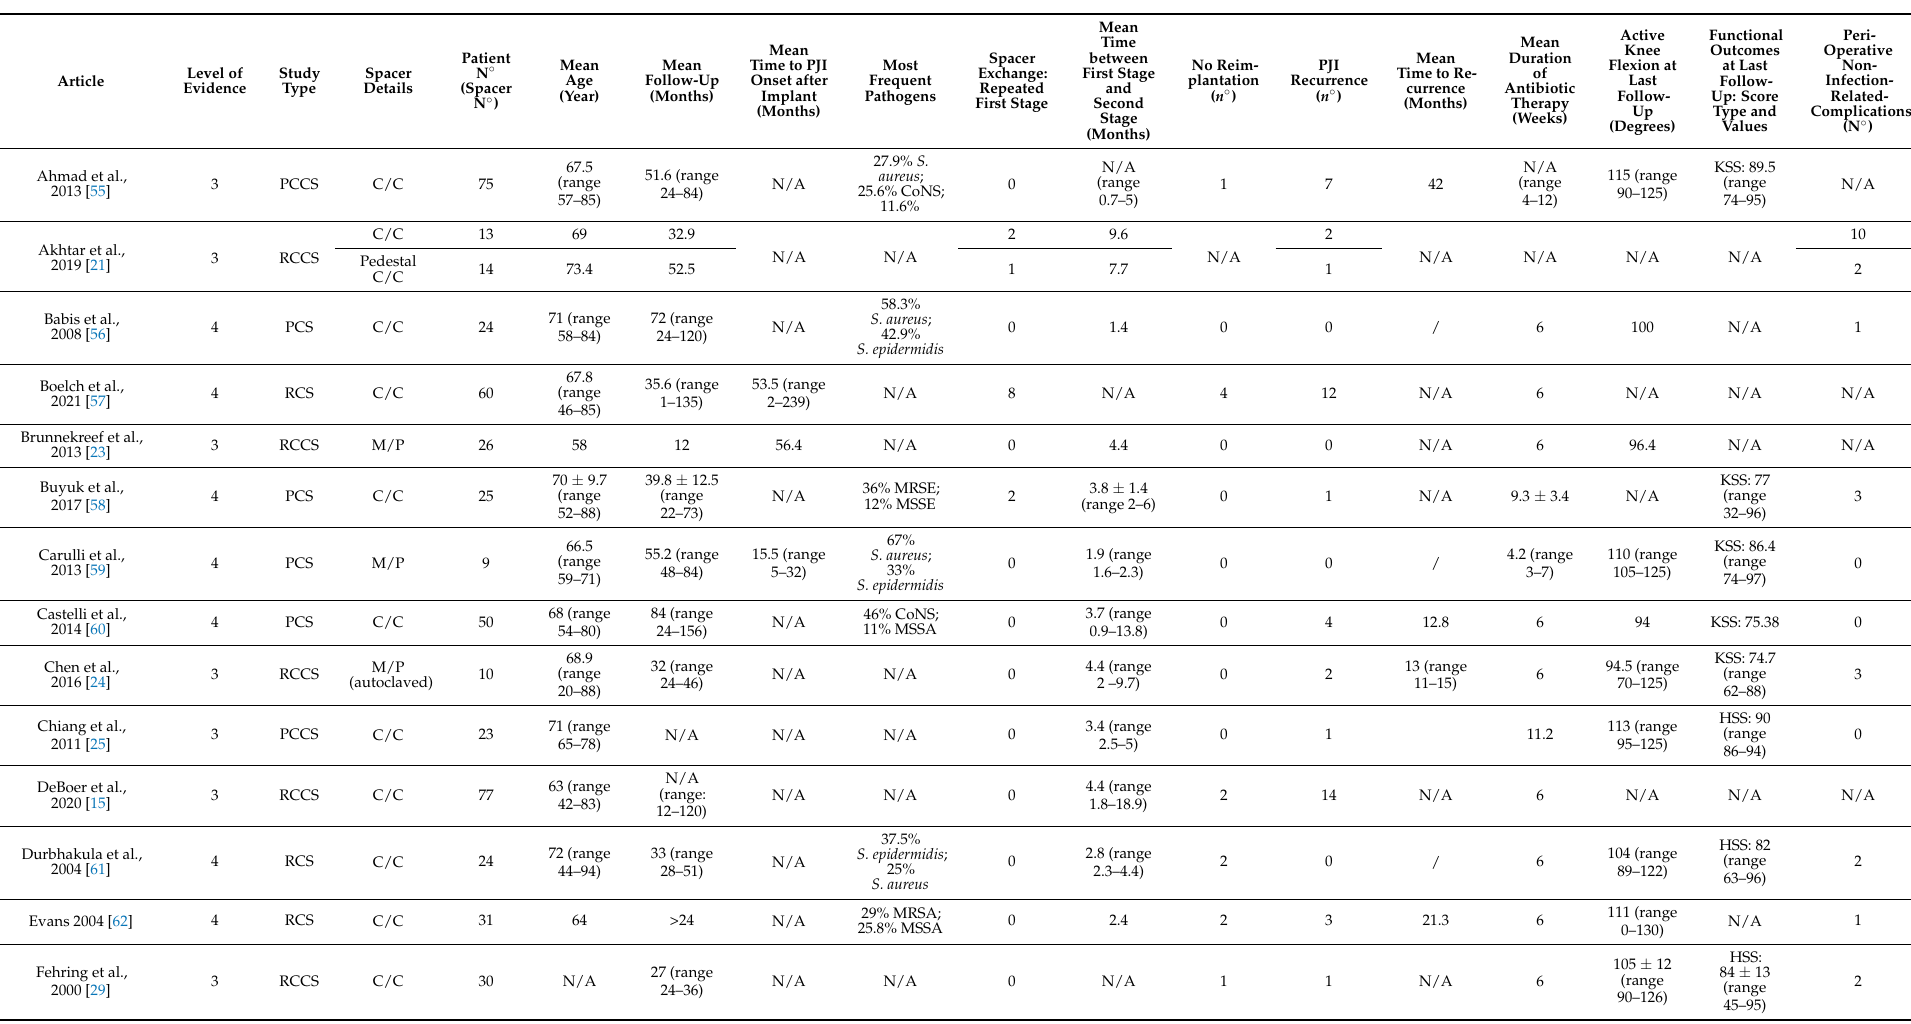
Table 2. Data from series reporting on articulated